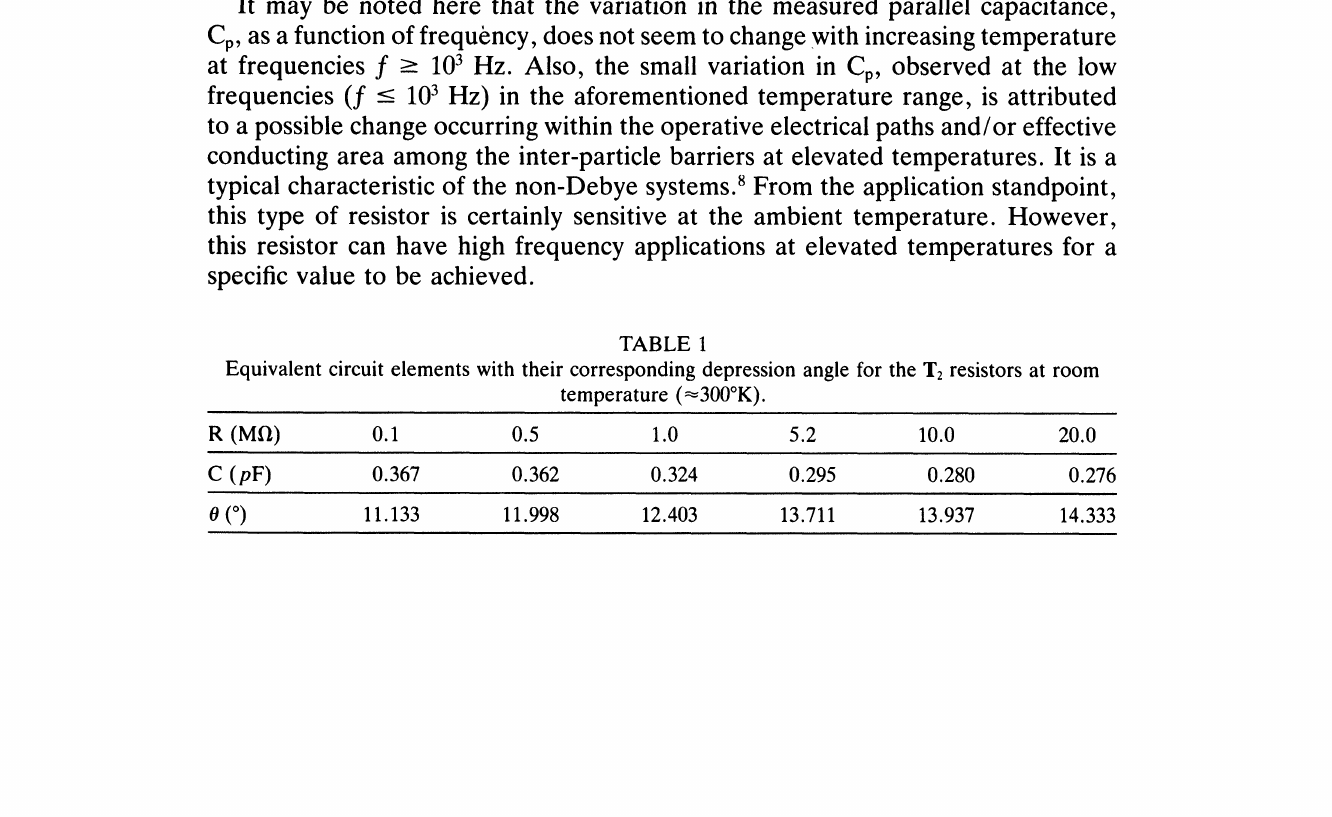
Equivalent circuit elements with their corresponding depression angle for the T2 resistors at room temperature